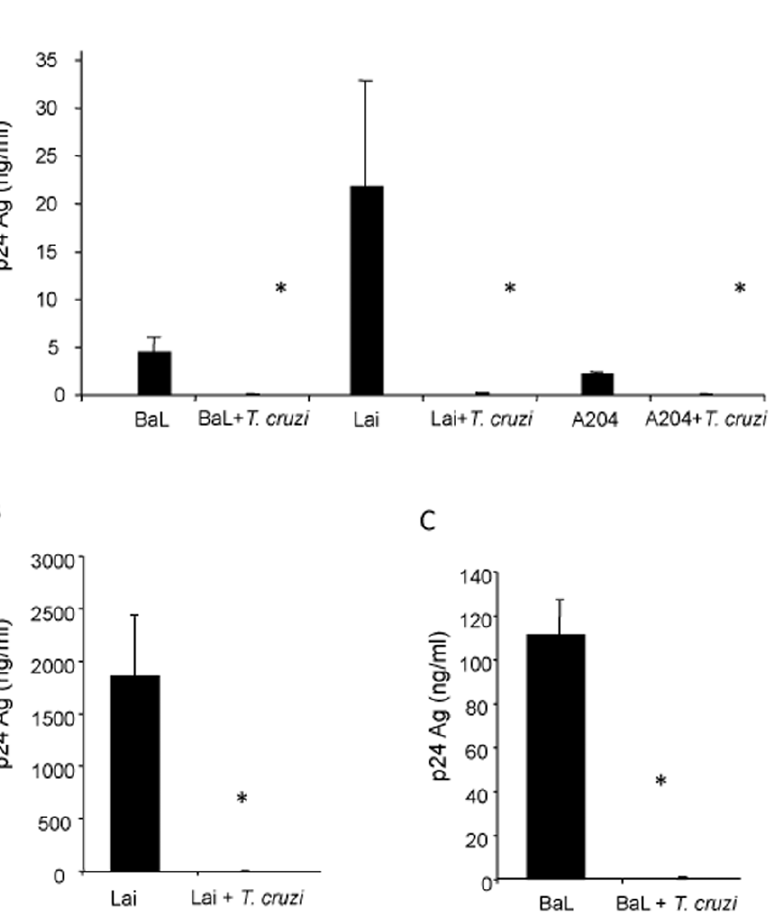
Figure 1. Inhibition of HIV-1 replication by T.cruzi in different cell types. Cells were infected with HIV-1 primary isolates with or without T. cruzi blood trypomastigotes and p24 production was measured at day 8 p.i. ( A ) PMBCs infected with R5 (BaL), X4 (Lai) and R5X4 (A204). ( B ) SupT-1 cell line infected with X4 (Lai) isolate and ( C ) MDM infected with R5 (BaL). Results are expressed as mean 6 SD, and are representative of at least 2 independent experiments. * p ,